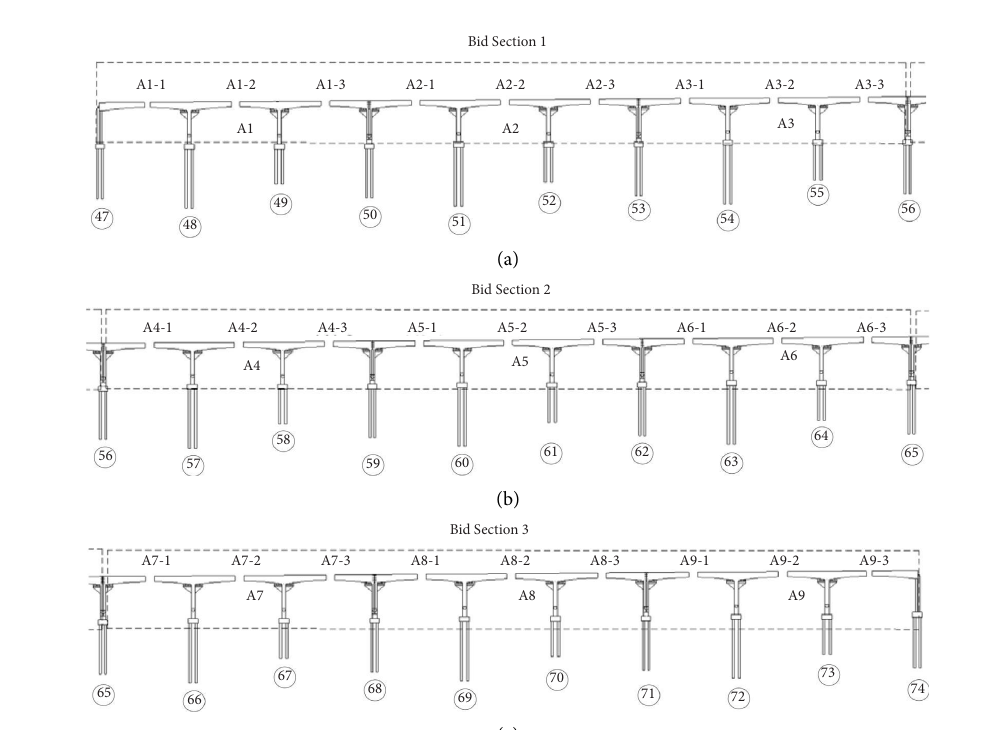
Figure 2: Tree construction bid sections are (a) bid section 1, (b) bid section 2, and (c) bid section